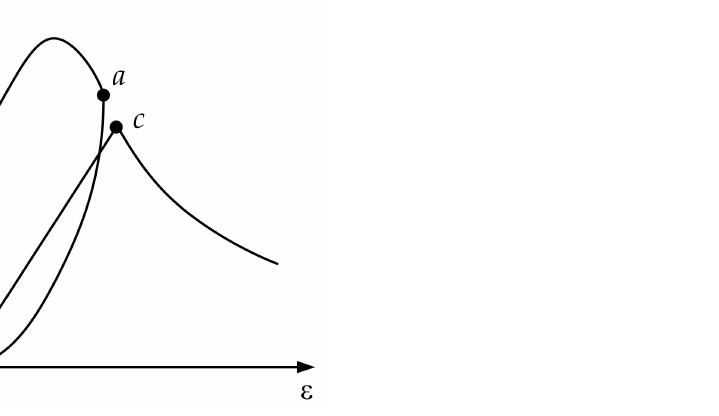
Figure 4. Complete unloading and reloading of the damage model (The letters a , b , c are points on the curve of the complete loading and unloading